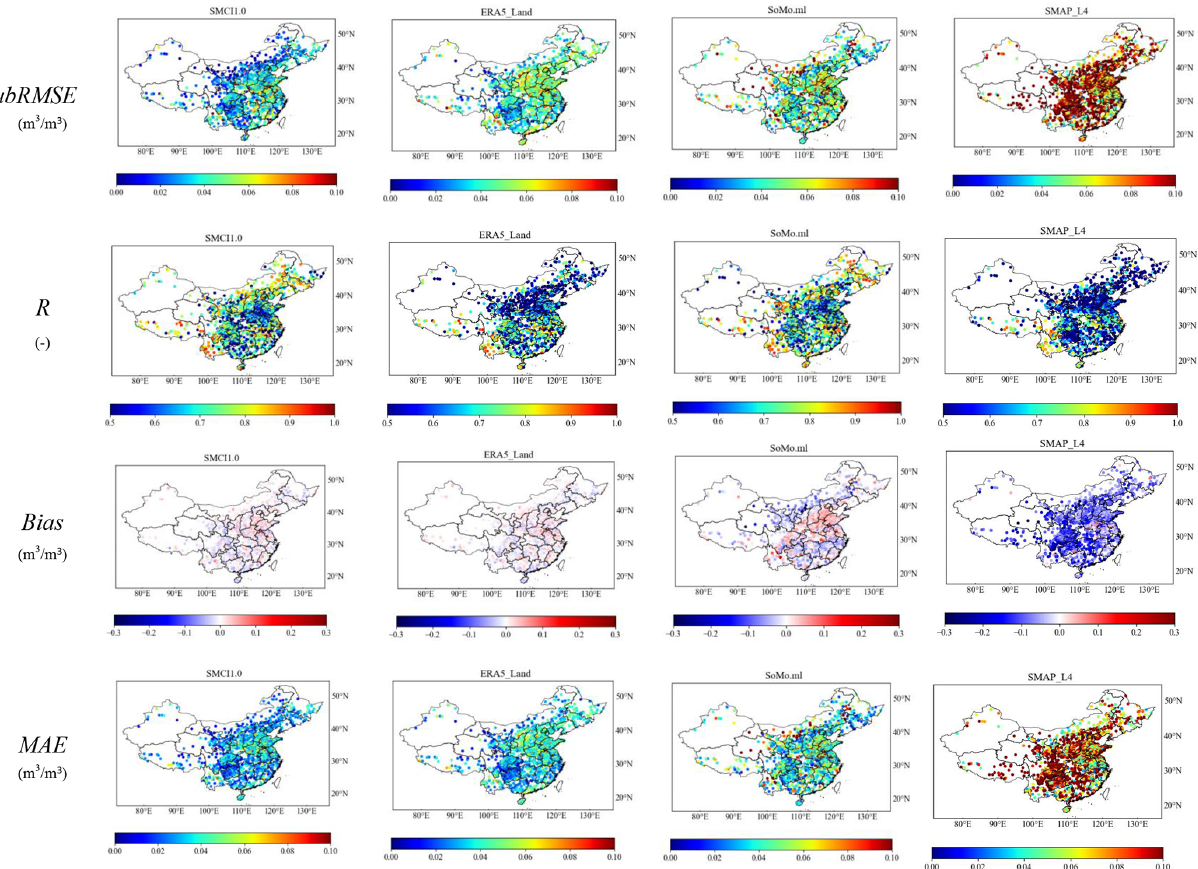
Figure 6. Goodness-of-fit statistics (ubRMSE, R , bias, and MAE) at 10cm soil depth for the RF model during the tested period.